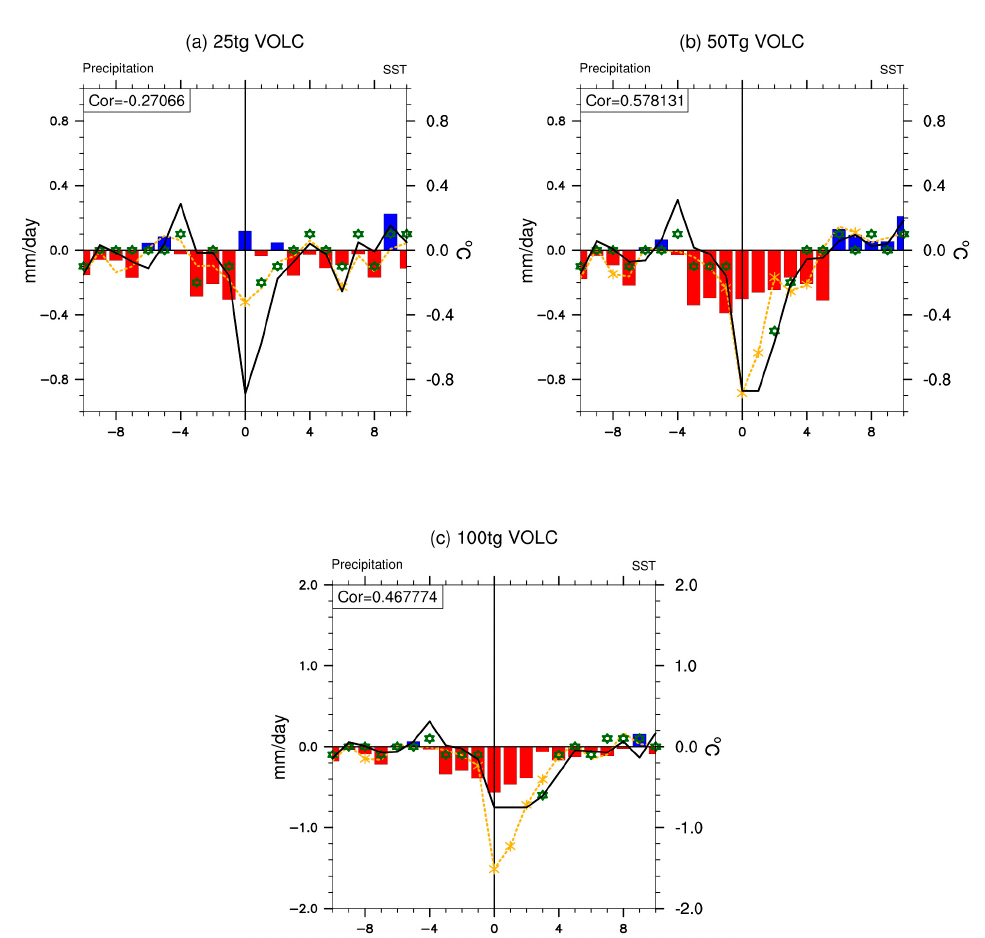
Figure 6. ( a )–( c ) The superposed echo analyses of precipitation anomalies (bar, left y-axis, unit: mm/day) in Eastern China, summer SST anomalies over the northwestern Pacific key region (123° E–150° E, 15° N–30° N; black line, right y-axis, unit: °C; Figure S8), variations of WPSH’s west ridge point (pink asterisk), grid number anomaly that is covered by WPSH (yellow line) from the volcanic forcing sensitivity experiments with volcanic eruptions of 25 Tg, 50 Tg and 100 Tg, respectively.